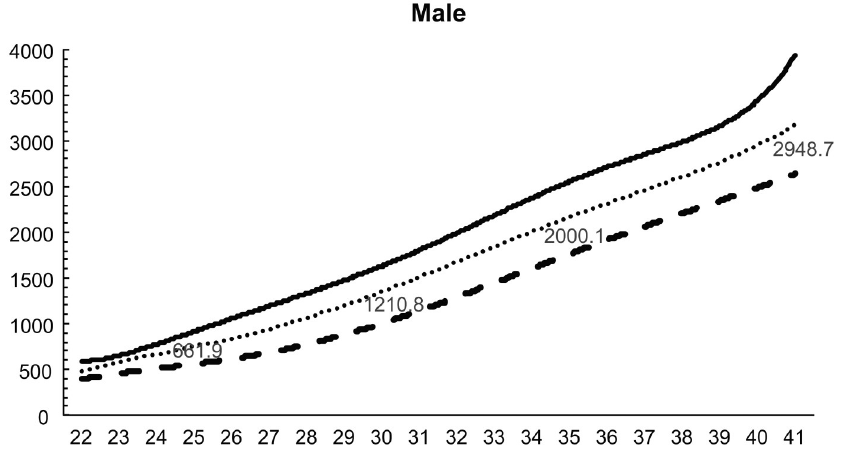
Fig 3. Birth weight reference curves for each week (male,